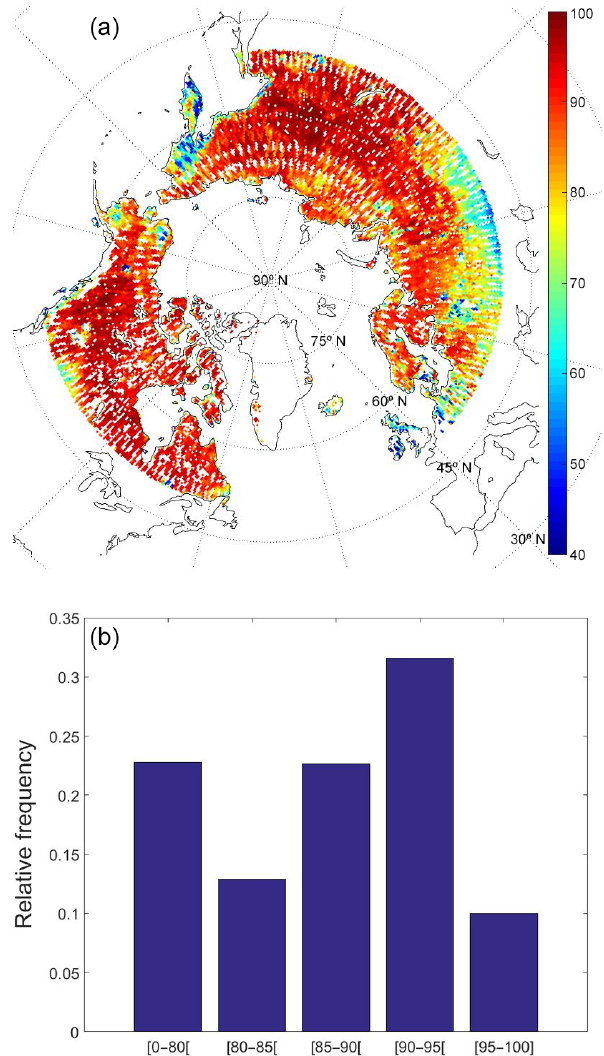
Figure 2. (a) Map of the percentage agreement between FT-AP and FT-ESDR classification for the whole period studied and (b) derived frequency distribution of the mean percentage agreement over the whole study area (lat. > 50 ◦